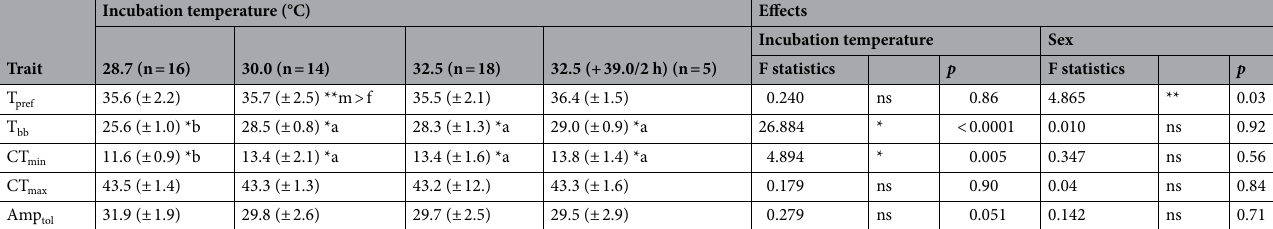
Table 4. Incubation temperature effects on thermal physiological traits of Tropidurus torquatus newborns under four incubation temperature regimes. Amp tol thermal-tolerance range, CT max critical thermal maximum, denotes the post-hoc difference among treatments; letters **m & **f denotes the post-hoc difference among sex; F, ANCOVA result; ns not significant; p , ANCOVA